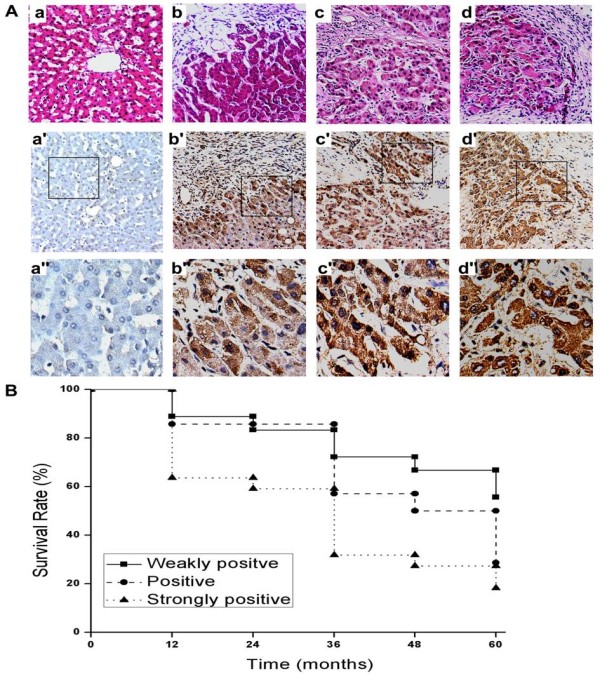
Immunohistochemical analysis indicated that overexpression of PGAM1 in HCCs was closely associated with the degree of differentiation and the lower survival rates. (A), staining against PGAM1 confirmed significant differences between normal liver tissues and hepatocellular carcinoma samples more likely to present poor differentiation (p < 0.05). a, normal liver tissue; b, well differentiated tissue; c, moderate differentiation; d, poor differentiation. a-d, representative HE staining; a'-d', expression of PGAM1 was examined by immunohistochemistry. a"-d", representative insets of a'-d'. Original magnification, × 200. (B), Kaplan-Meier survival curves showed the correlation between higher levels of PGAM1 expression and lower survival rates (p < 0.05).